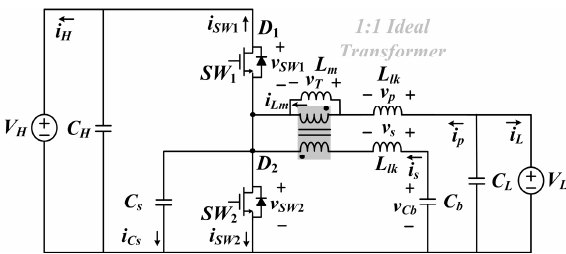
Figure 3. Circuit structure of the converter of [15]. Adapted from Choi, Y.G [15].